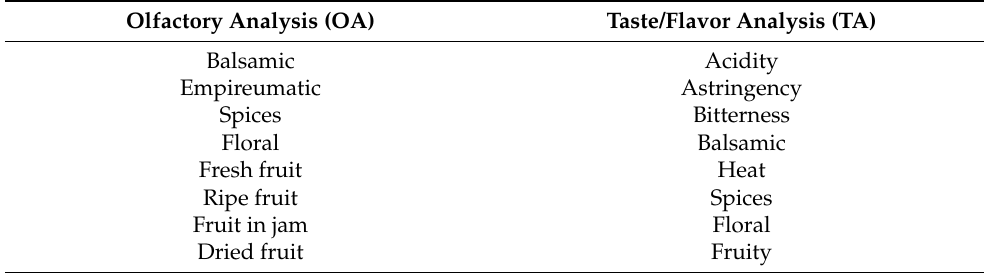
Table 3. List of attributes designated for application of the TDS